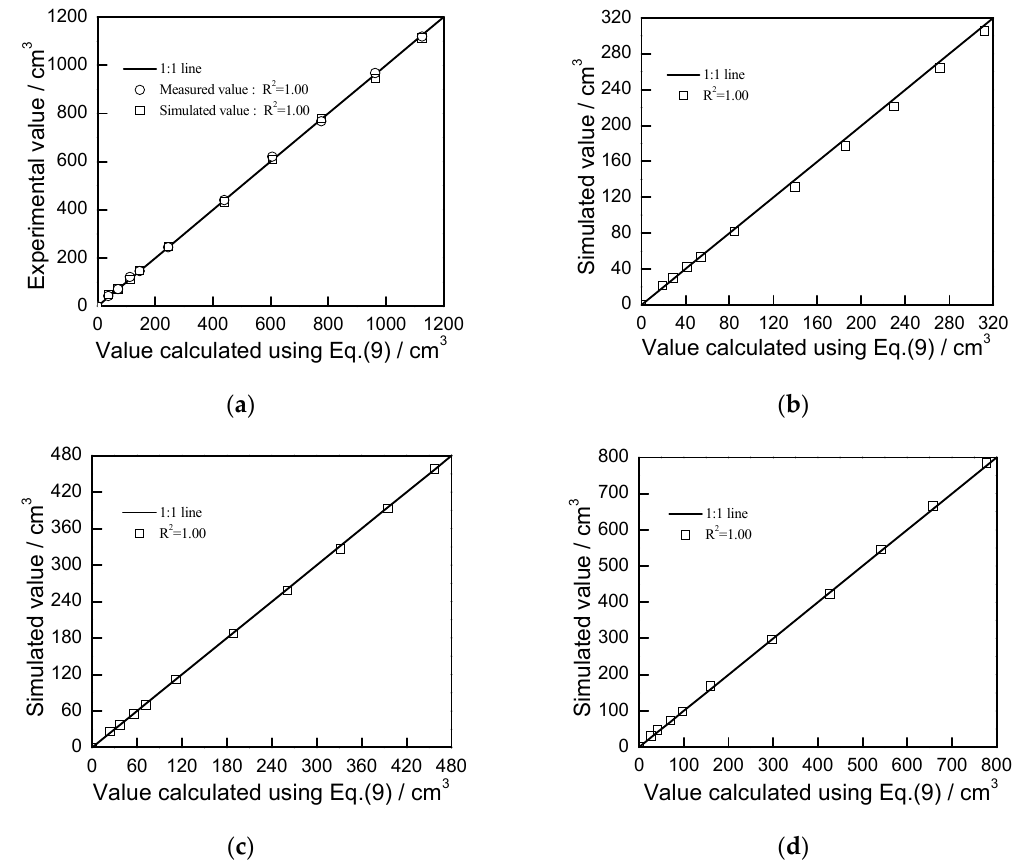
Figure 9. Comparison of cumulative infiltration calculated using Equation (9) and of the Experiments: ( a ) Xi’an silt loam; ( b ) Silt; ( c ) Silt loam; ( d ) Loam.